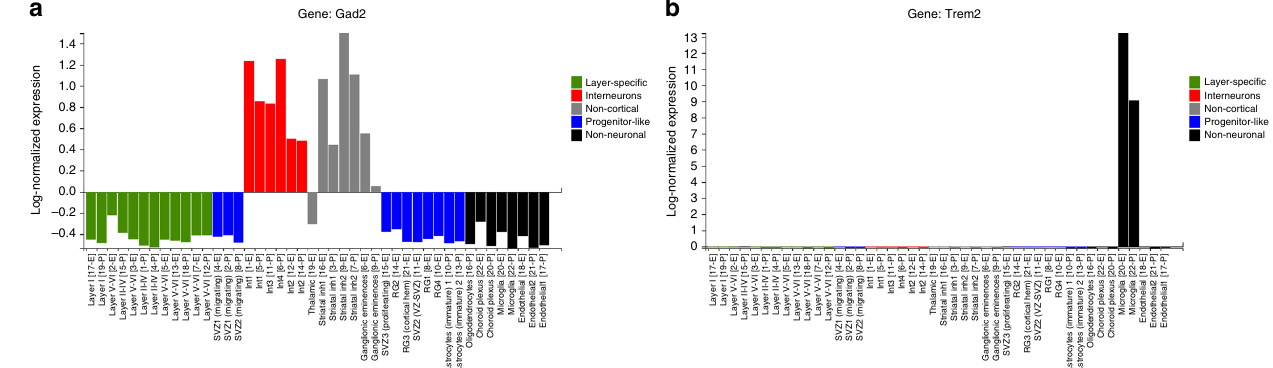
Fig. 6 Snapshots of the web-based data visualization tool. a , b . Normalized expression (mean of all cells within cluster) of query genes illustrated as a live and exportable barplot 14.5 (E14.5) embryos were collected for dissections. For P0 pups, cages were monitored daily from E18.5 to postnatal day 0 (P0) for newborn pups. Cortical dissections and single cell suspension preparation . Cerebral cortices (both halves) from E14.5 and P0 mice were dissected in neurobasal medium and rinsed with Hank ’ s Balanced Salt Solution (HBSS; 14175095 Gibco) 61 . All proce- dures were done at room temperature, unless otherwise stated. Cortices were then incubated for 30 min at 37°C in papain (1 vial diluted with 2.5mL of HBSS; Pierce 88285) with DNase I (20 mg mL − 1 ; D4513 Sigma) in Ca 2 + and Mg 2 + free HBSS. Next, 1mL of neurobasal medium containing 5% FBS was added to the cortical mixture and triturated to deactivate the papain. The cells were centrifuged for 2 min at 4600 × g , washed twice, and resuspended in Ca 2 + and Mg 2 + free HBSS with ion channel inhibitors (5µM TTX ab120054 Abcam, 25µM DL-AP5 ab120004 Abcam, 5µM DNQX 2312 Tocris). Cells were kept on ice until the micro fl uidics run. A total of nine replicates were prepared from two developmental time points (6 replicates for E14.5 embryos and 3 replicates for P0 pups). Each replicate contained cortical cells from male and female littermates.